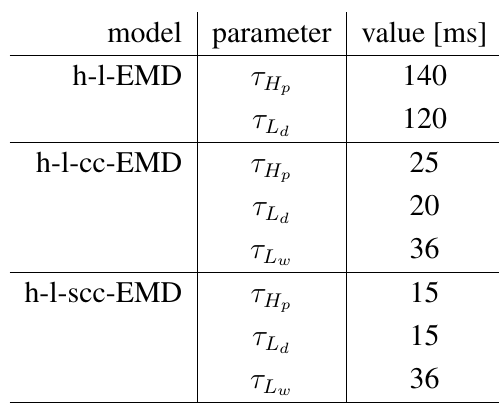
Table 2. The time constants used for the different filters in the examined EMD